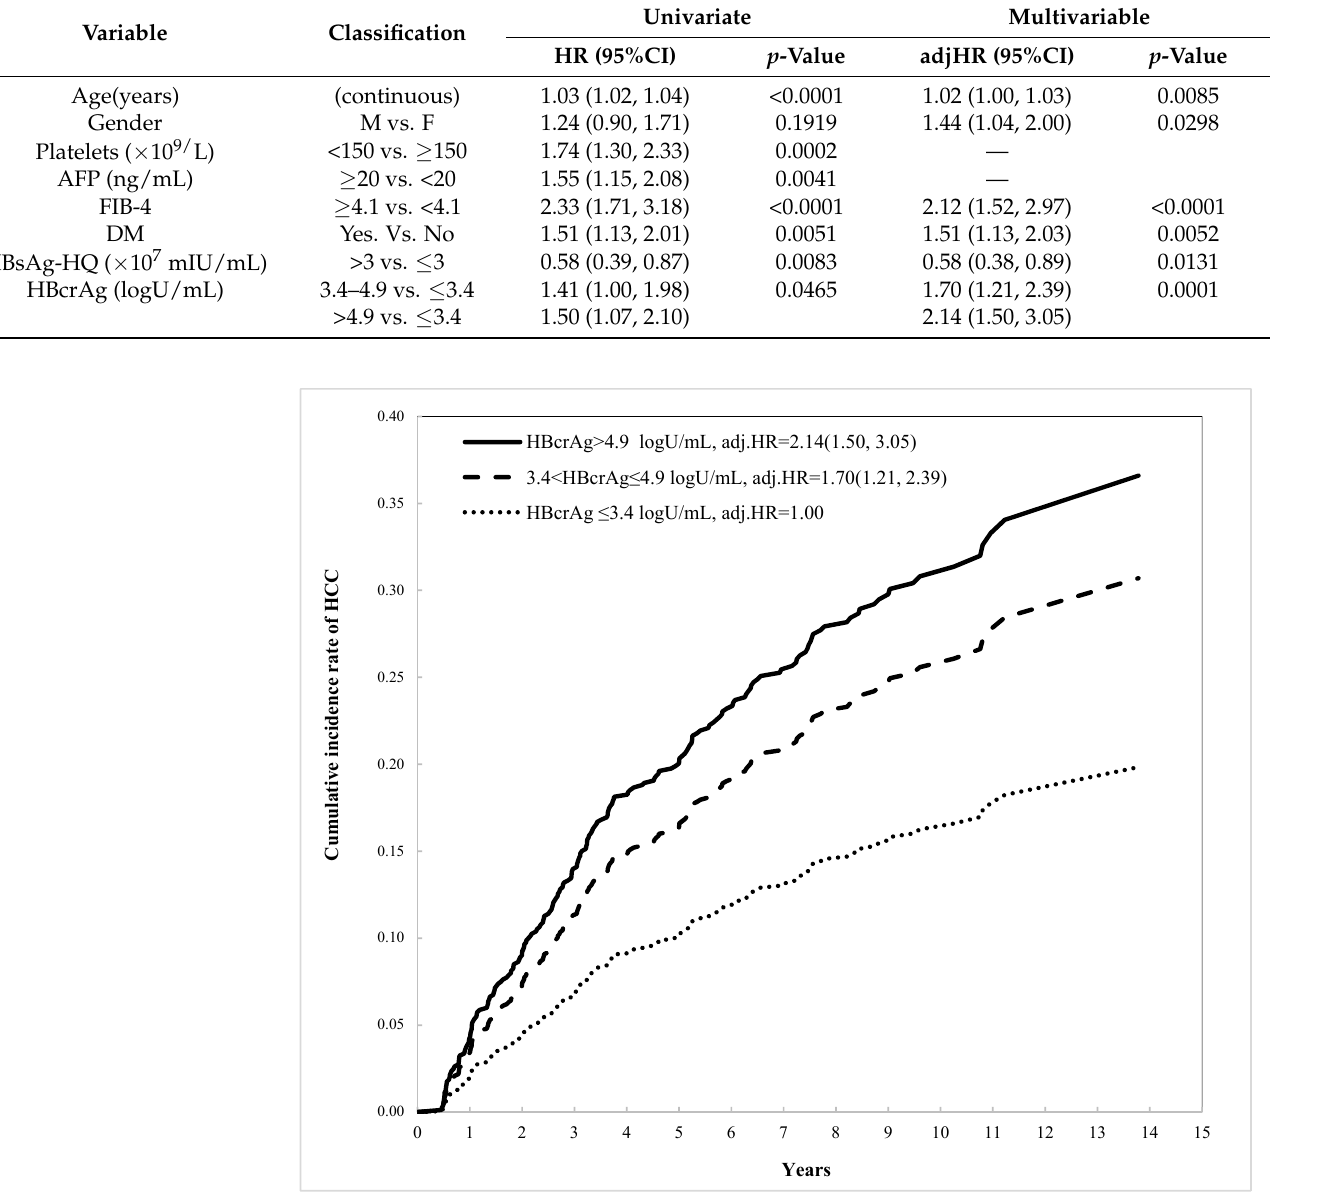
Figure 1. Cumulative incidence rate of HCC by HBcrAg level. Table 3. Univariate and multivariable analysis for risk factors associated with the development of hepatocellular carcinoma in patients with a virological response.